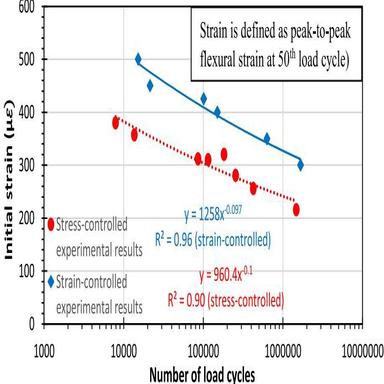
Comparison of flexural fatigue results in stress-controlled mode and strain-controlled mode .